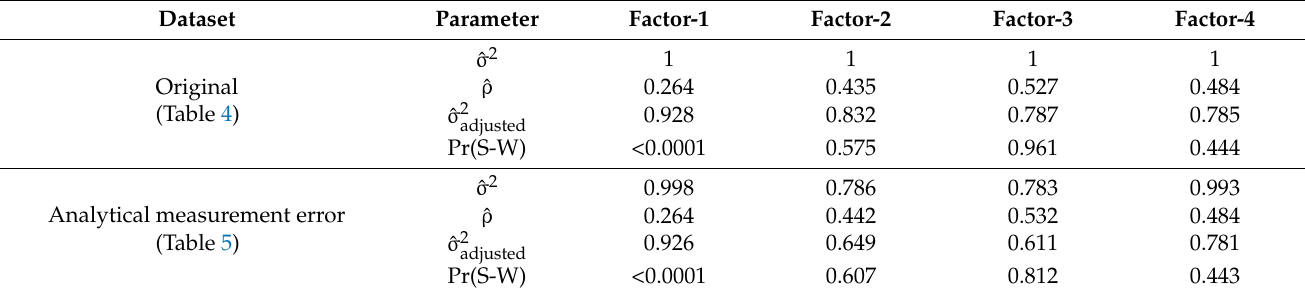
Table 12. Factor variance estimates based upon a spatial simultaneous autoregressive model specification and census tract aggregated heavy metal